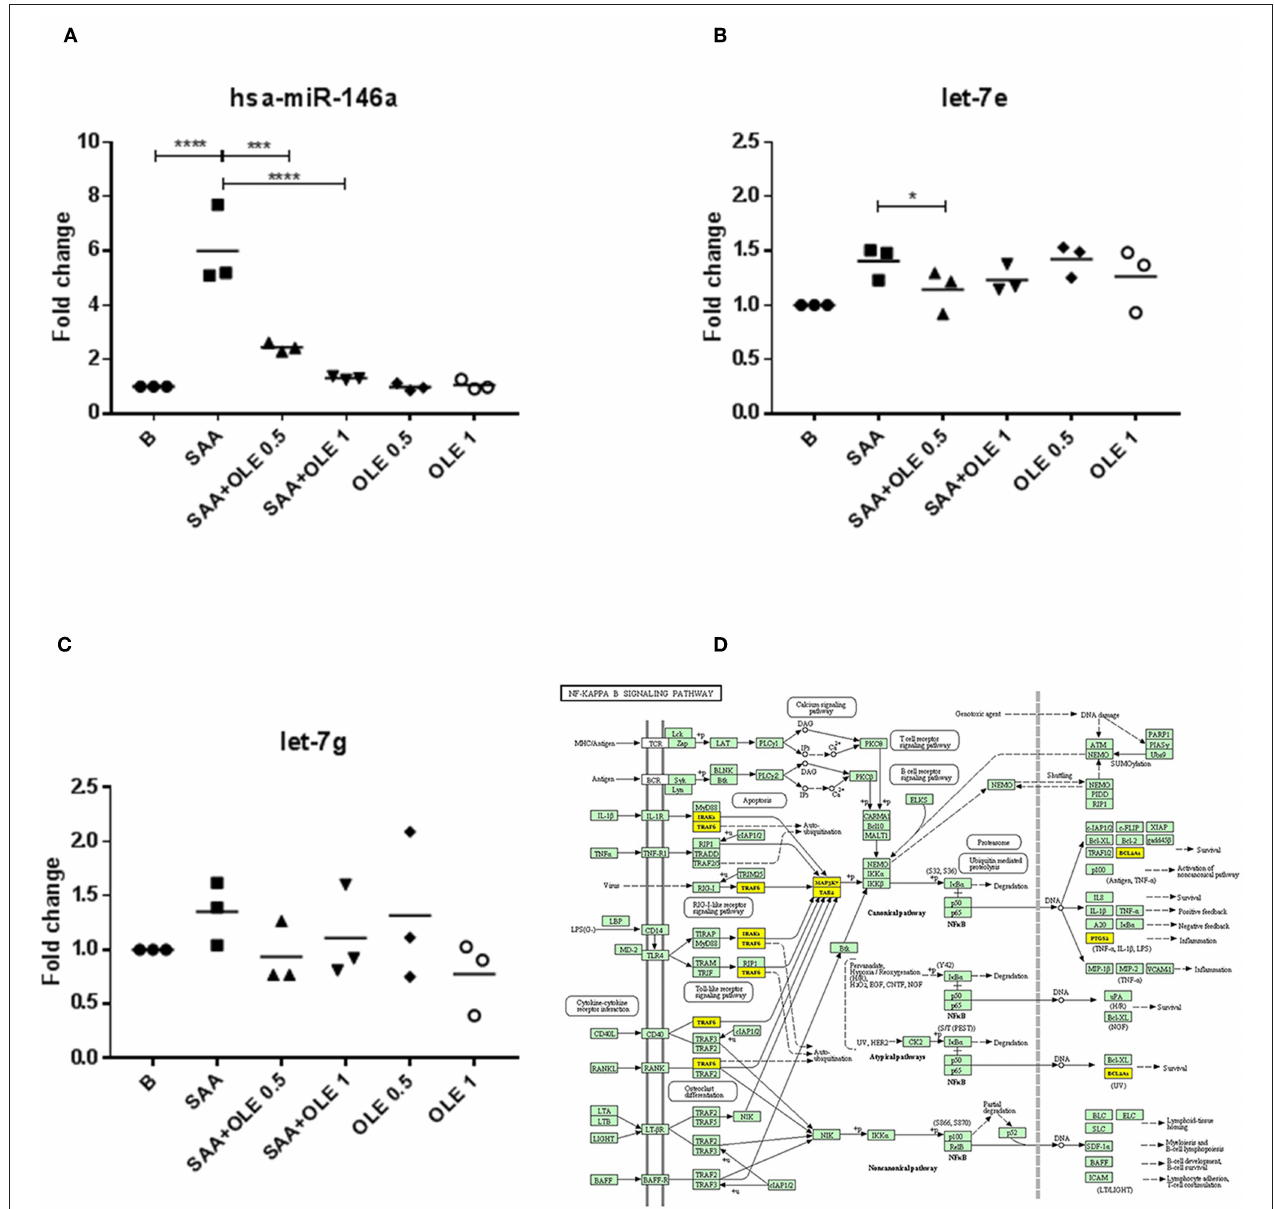
FIGURE 5 | OLE regulates SAA-induced miR-146a and let-7e. (A–C) represent fold changes of mRNA expression levels of miR-146a, let-7e and let-7g, respectively. The mean is shown of 3 biological replicates. Data was analyzed using RM one way ANOVA test with Tukey’s multiple comparison test p -values are shown as